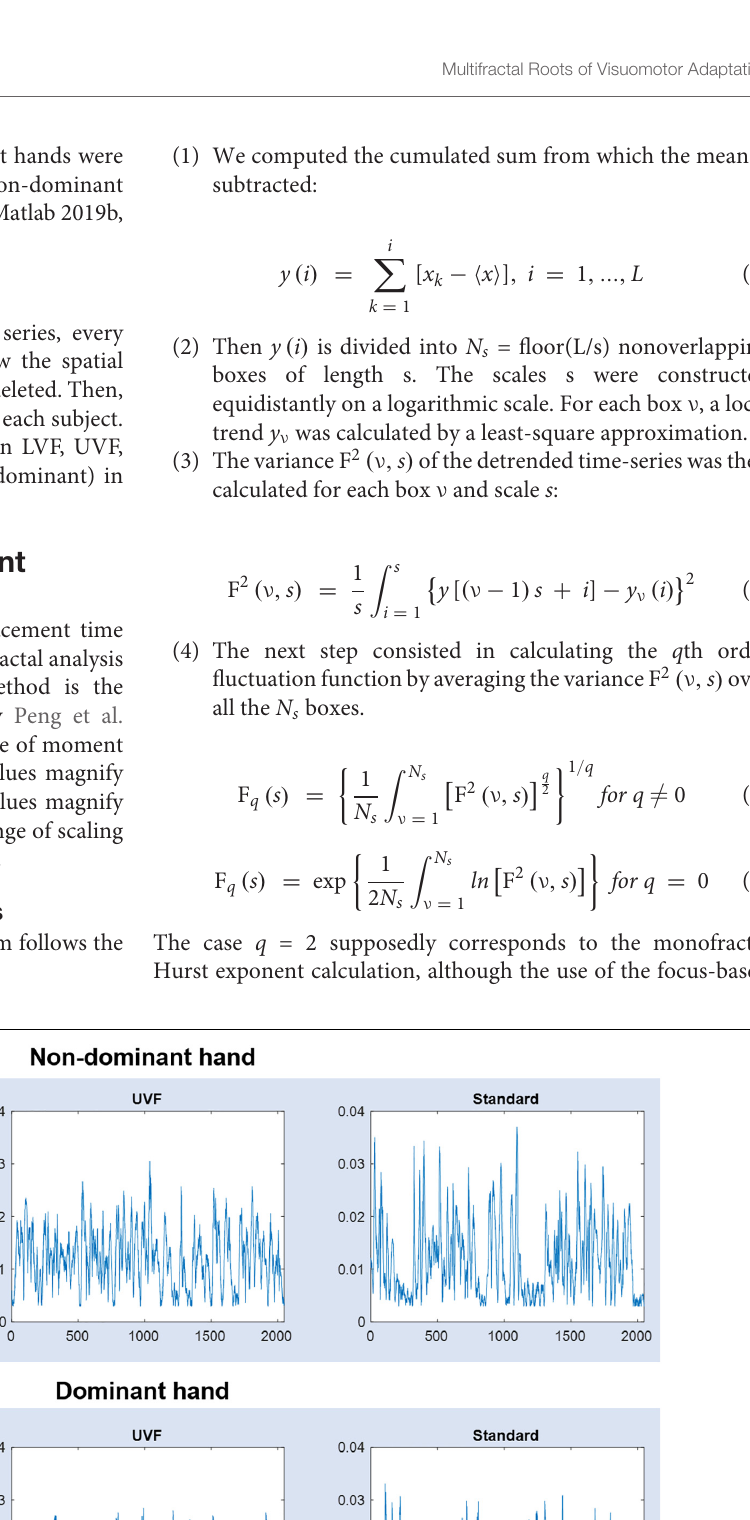
Frontiers in Physiology |